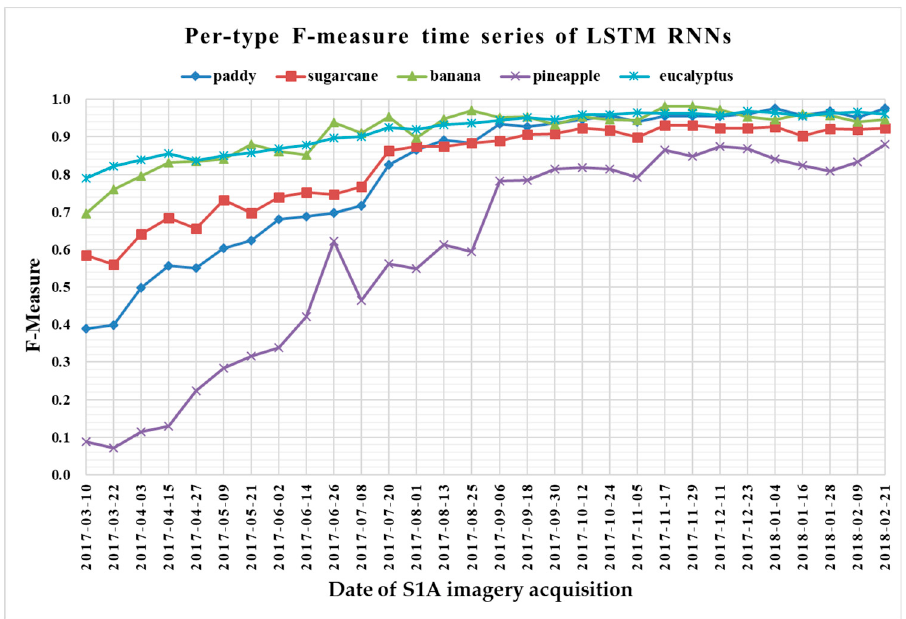
Figure 14. F-measure time series of long short-term memory recurrent neural networks.